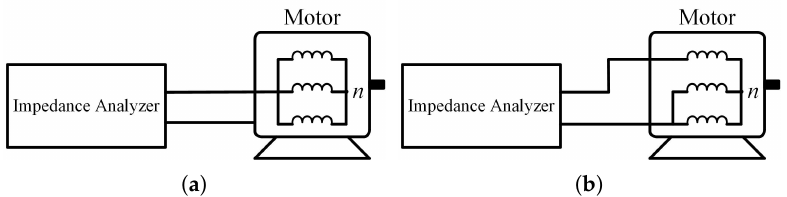
Figure 3. Measurement of the CM and DM impedances of the motor: ( a ) CM impedance, ( b ) DM